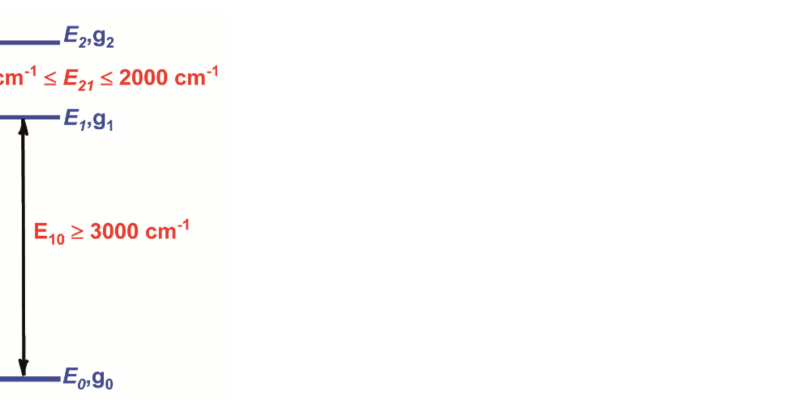
is the spontaneous emission ij